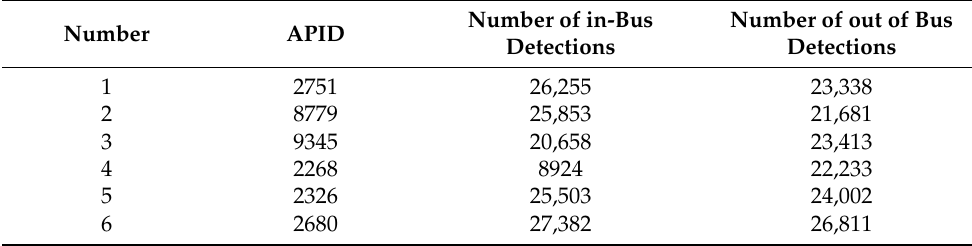
Table 1. The performance of Wi-Fi probe.